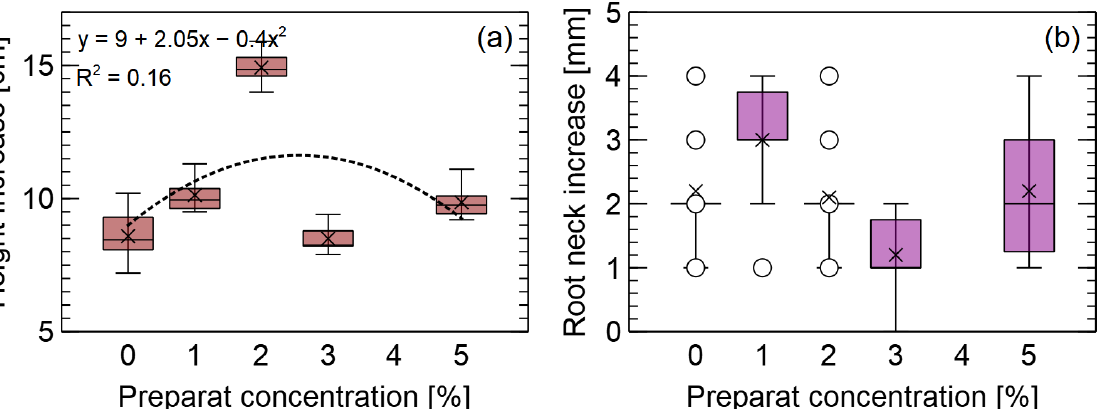
Figure 8. Oaks’ seedlings’ height ( a ) and root neck size ( b ) increase. Difference between the magni- tudes at the end and the beginning of the experiment periods. In sub-Figure ( a ), the dashed curve represents the linear regression fit of the data. The regression equation with the fitted parameters and the model’s R 2 values are printed. The regression parameters are statistically significant at p < 0.002. For the case presented in sub-Figure ( b ), the regression parameters were not statistically significant at the p -value level of 0.05, thus, the fit is not presented. In the plot, boxes span from the 1st to 3rd quantile, with the median indicated by a line, whiskers indicating a 1.5 inter-quantile range, the × symbol indicating the mean value, and circles indicating outlier observations.